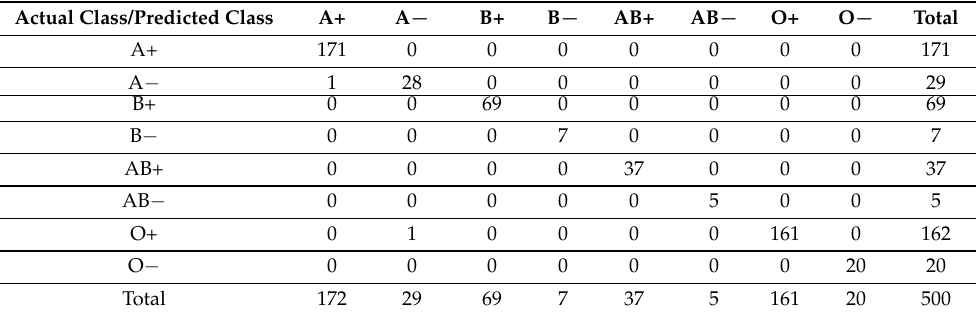
Figure 23. Results summary for the evaluated systems over the 500 samples. Table 17. Confusion matrix for the optimized ORB algorithm over the 500 blood